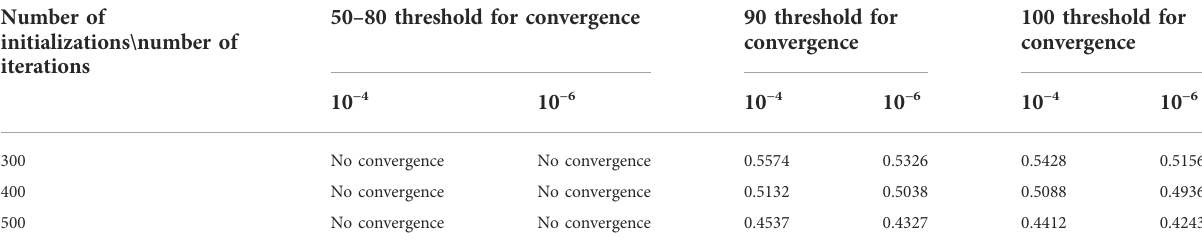
TABLE 2 Loss of mutual information with different settings of numbers of iterations and initializations and the threshold for convergence for the air pollutant dataset. Number of initializations\number of